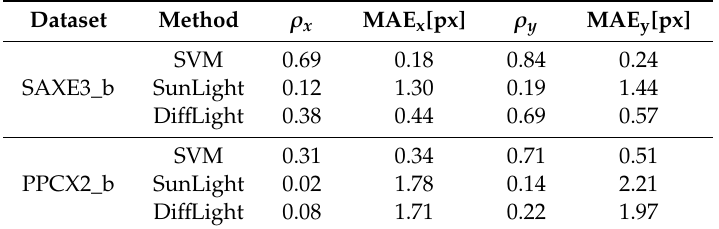
Table 6. Correlation ρ and MAE of two dimensions for dataset